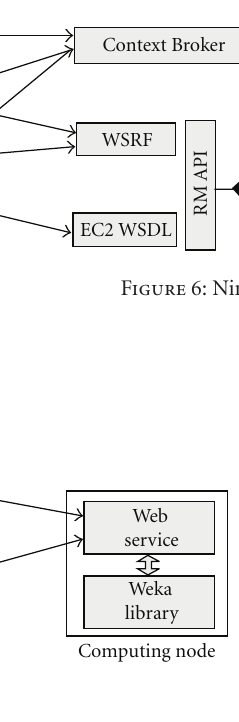
Figure 7: Weka4WS